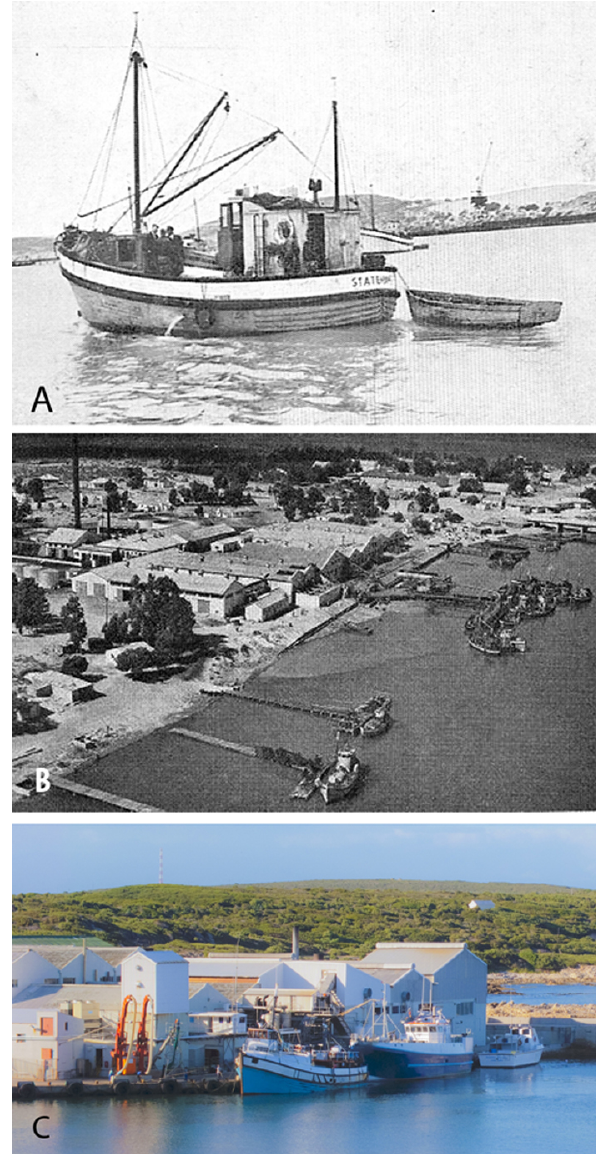
Fig. 2 . A. Early west coast sardine boat (from Davies 1957 as reproduced in Hutchings et al. 2012). B. Velddrif, in St. Helena Bay, during the times of rapid growth in the small pelagic fishing industry (early 1950s) (from http:// trawlerheritage.co.za/Fishing%20Harbours%20and% 20Factories/AIF%20Velddrif/Velddrif.htm). C. Purse seiners alongside the factory jetty in Gansbaai (2010). Note older wooden vessel in the front, modern small fibreglass vessel